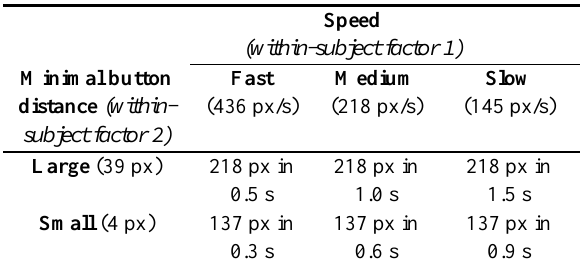
Table 1. Resulting single button movement characteristics.